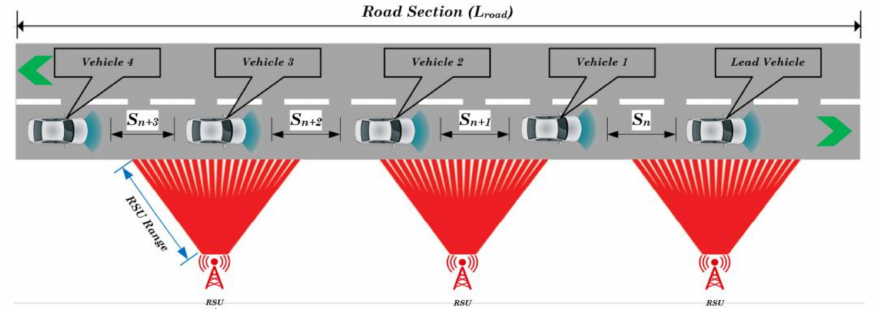
Figure 5. V2X enabled platoon vehicles in physical world environments.